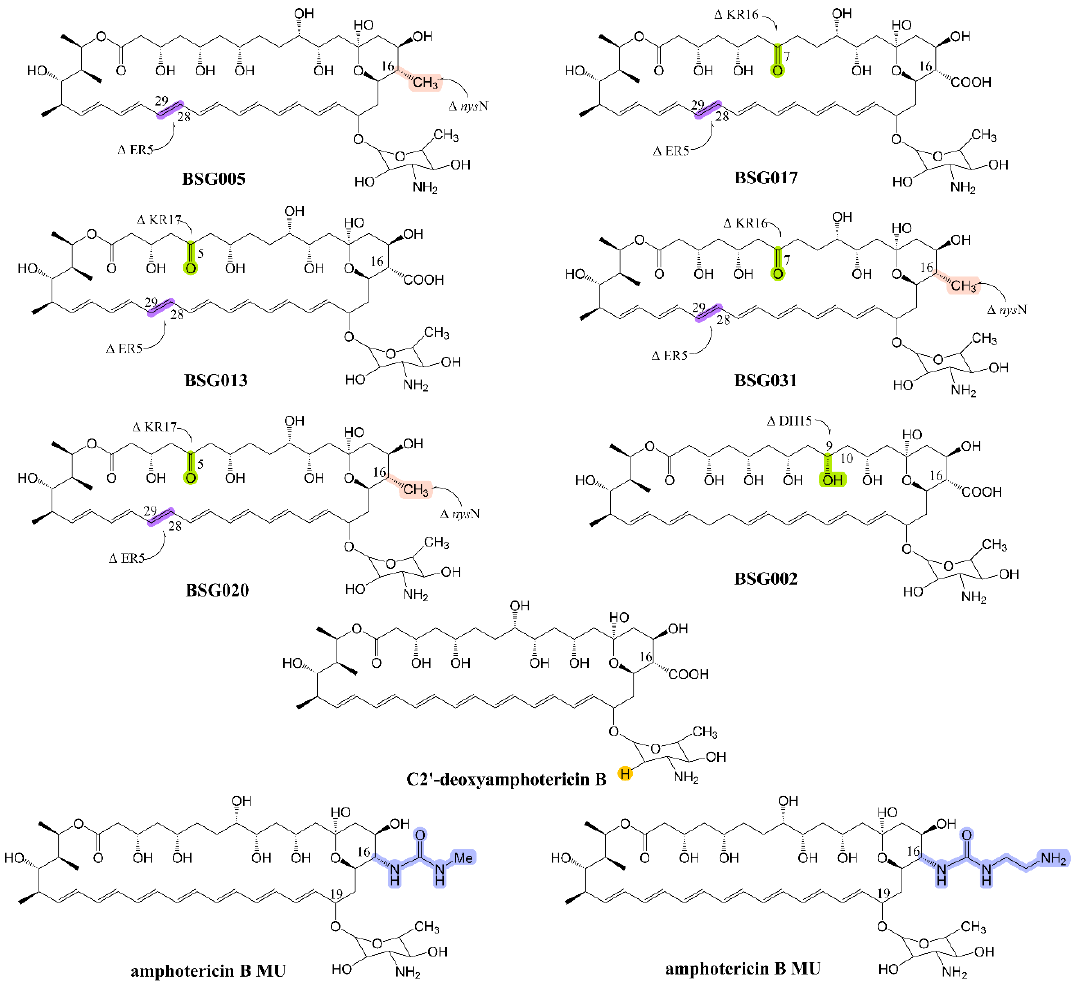
Figure 1. Structures of polyene macrolides and they derivatives. ( a ) Initial polyene for structural modification. ( b ) Polyene related to the modification of the carboxyl group, a derivative C2 ′ -deoxyamphotericin B modified on the glycosyl, is added to facilitate the structure comparison; highlights represent differences from the initial